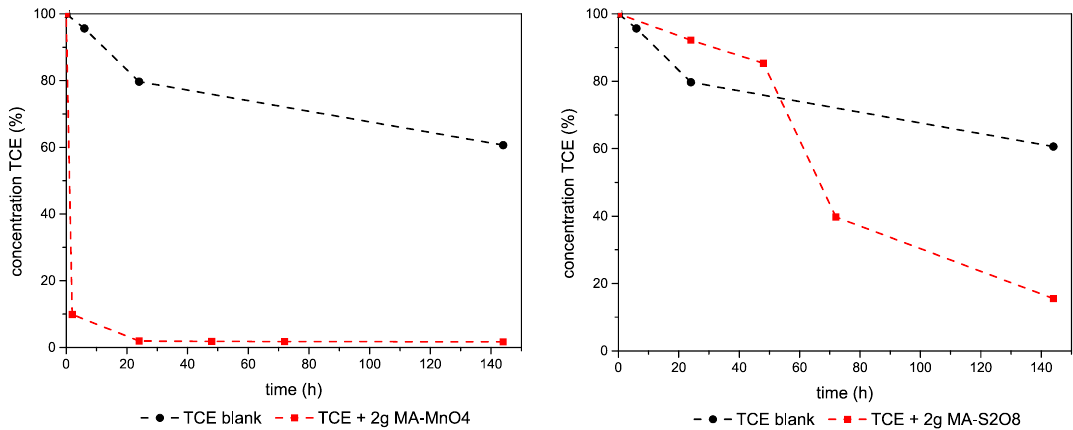
Figure 4. Results of the HS-PTV-GC-MS measurements with permanganate ( left ) and peroxydisulphate ( right ) intercalated MA–LDHs using trichloroethene as the contaminant. Contaminant concentration (%) in solution over time (h). Blank solution as black dots, experimental solution as red squares.